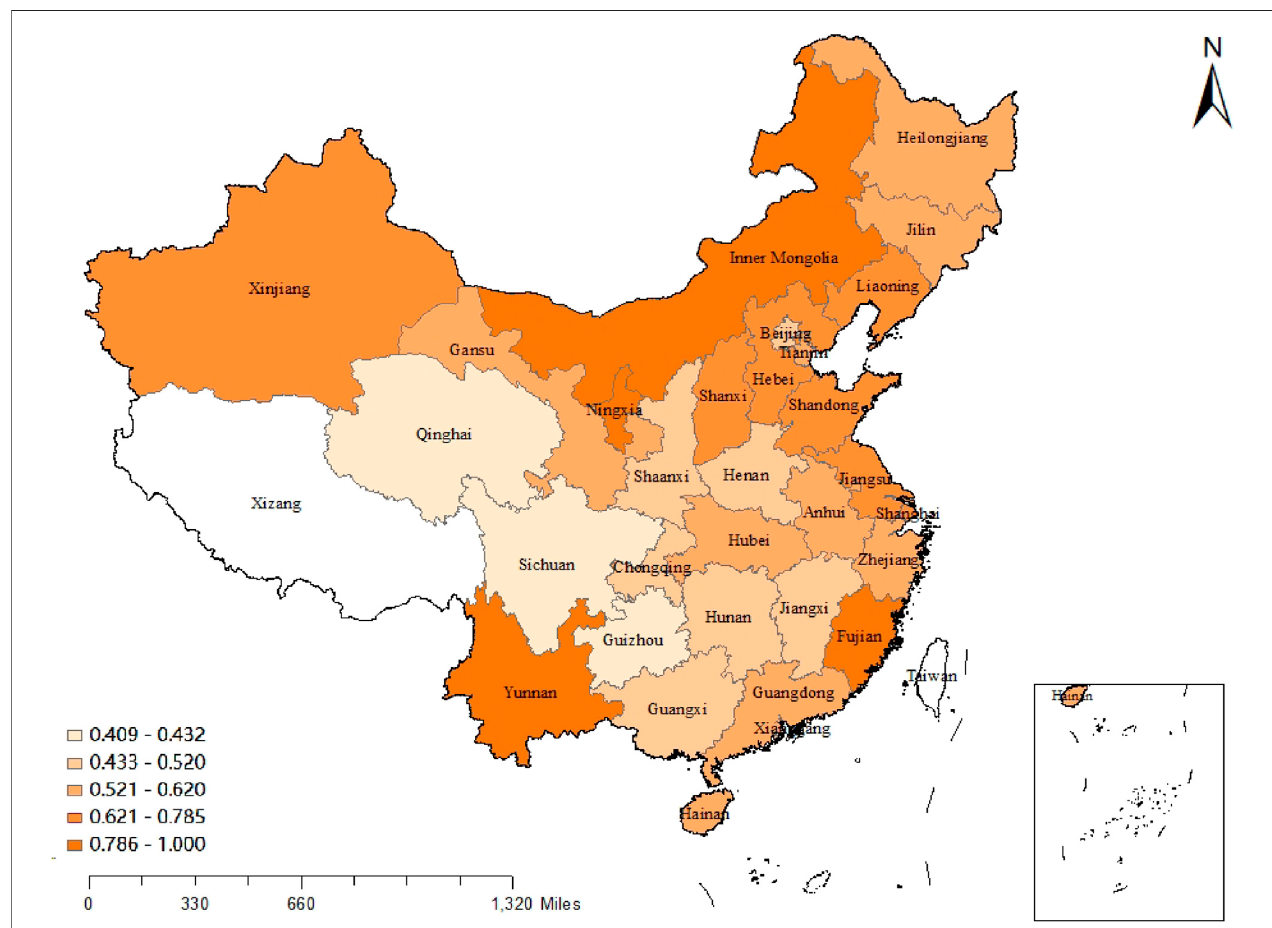
FIGURE 4 | Average annual overall ef fi ciency in various